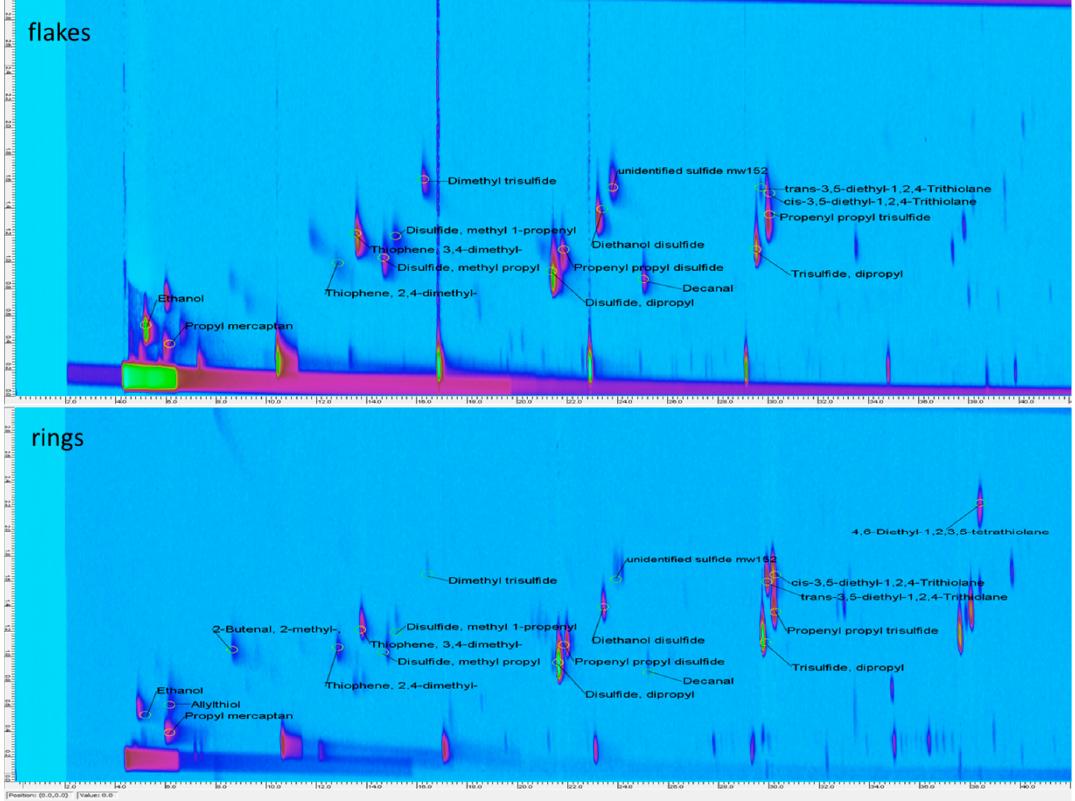
Figure 2. Comprehensive two-dimensional chromatography–mass spectrometry (GC×GC-TOF) color diagram and comprehensive template matching fingerprinting with the main identified volatile compounds of onion flakes and rings. Table 3. Main volatile organic compounds detected by HS-SPME-GC×GC-TOF in the different onion samples. Data are the mean of three determinations. First dimension retention time in minute (1st D RT). Second dimension retention time in second (2nd D RT). Response of the two-dimensional peak (volume). Relative amount (%) calculations were based on the ratio between the peak volume of each compound and the sum of volumes of all selected compounds. Not detected (n.d.).